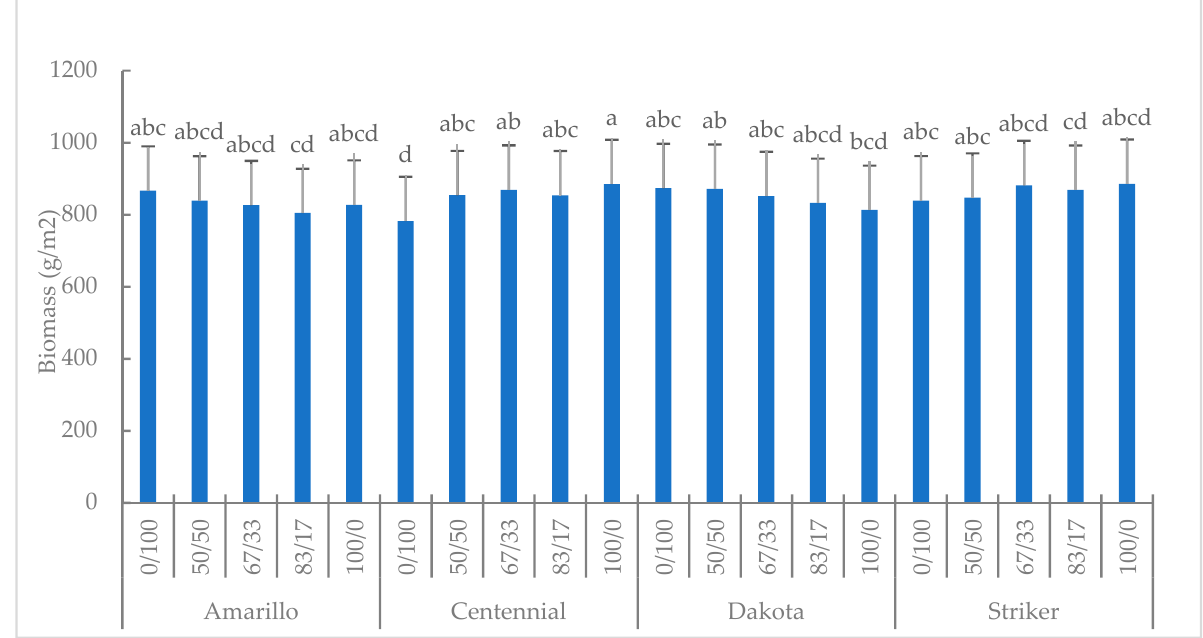
Figure 5. Height reduction by image estimation on leafed: semi-leafless pea ratio based on the combined varieties. The Mean of three site-years, one in 2018, and two in 2019. Means with different letters (a–c) are significantly different. The error bar represents the positive standard error in LSD 0.05 .